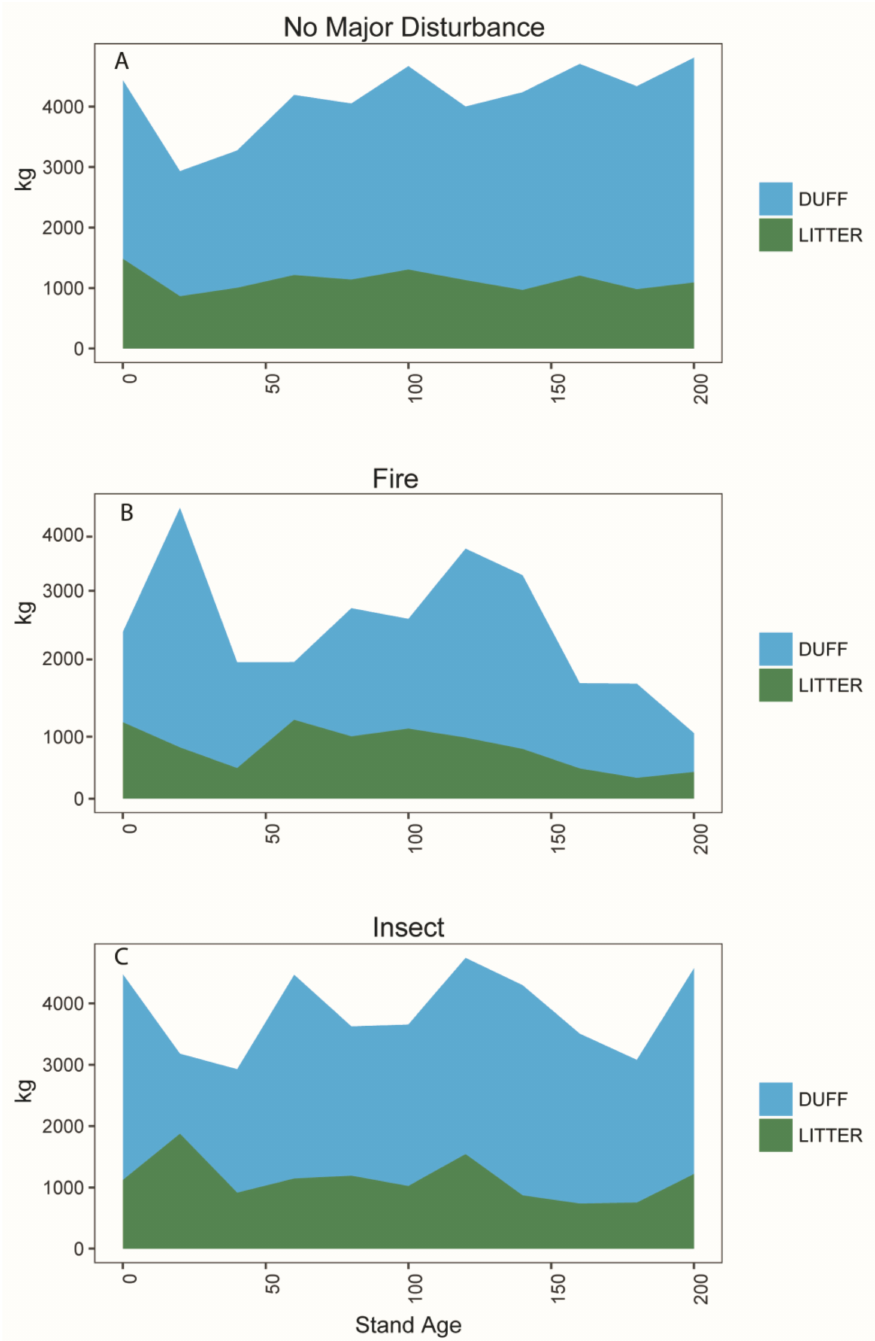
Figure 5. Stacked line graphs representing mean duff and litter carbon loading (kg) across a range of stand age classes for ( A ) stands with no major disturbance, ( B ) fire-affected stands, and ( C ) insect-infested